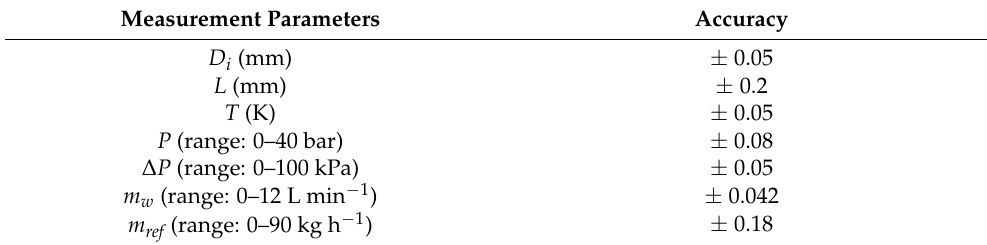
Table 2. Accuracy of the primary parameters.